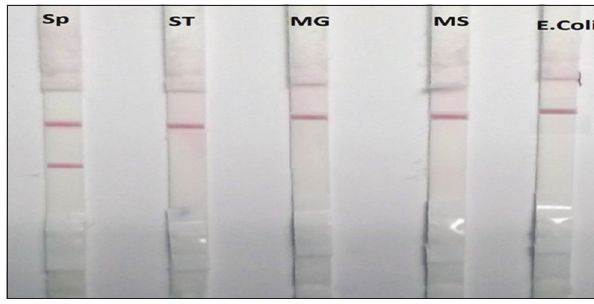
Figure-3: Specificity test for Salmonella Enteritidis-lateral flow immunochromatographic test.